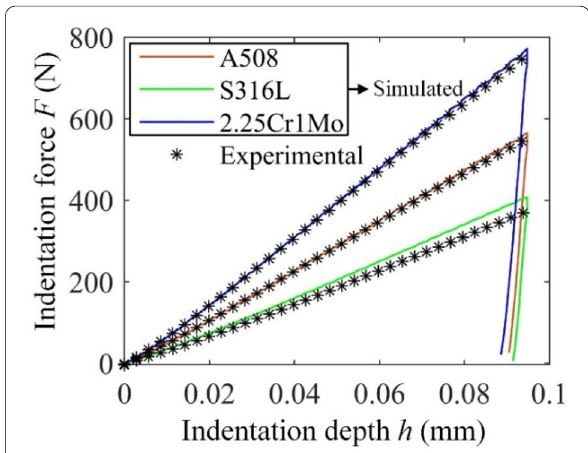
Figure 6 Indentation force-depth curves measured from experiments and extracted from FE model with material parameters presented